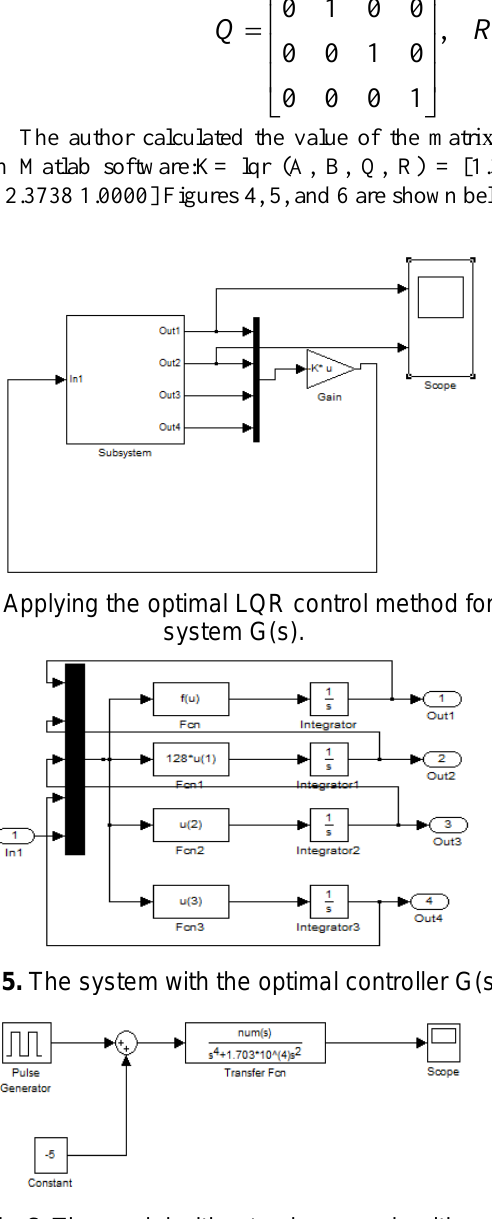
Fig 6. The model without using any algorithm.